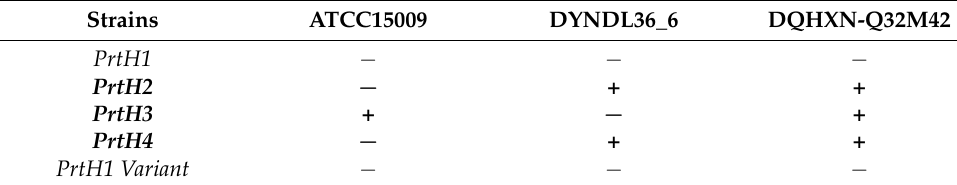
Table 1. Distribution of CEP genes in experimental